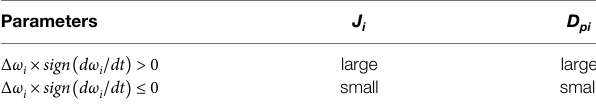
TABLE 2 | Rules of J i and D pi . Parameters